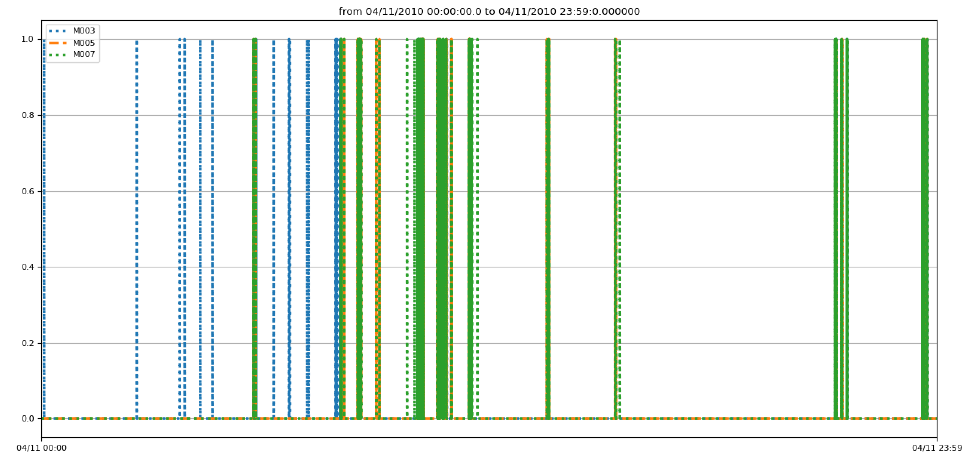
Figure 10. Sampled detection motions.